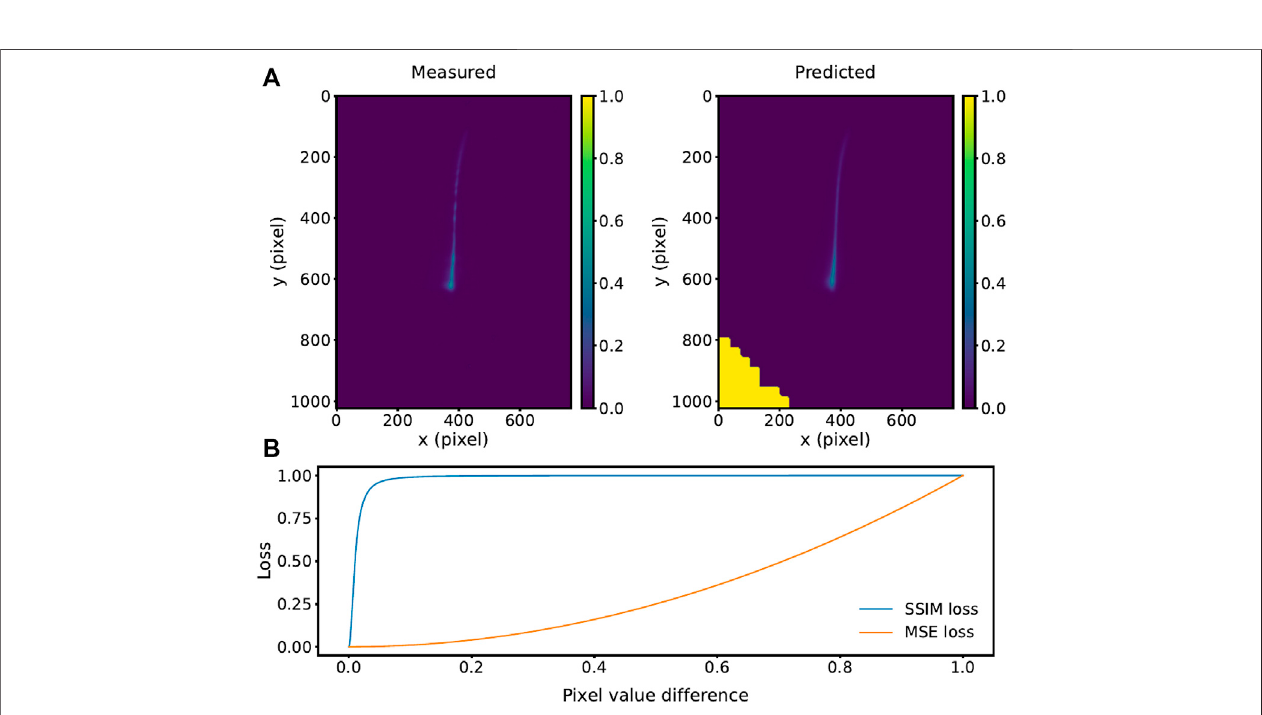
FIGURE 4 | (A) Example of a prediction from a model trained using only the multiscale SSIM loss for the LPS image decoder. The pixel values near the lower-left corner of the predicted image are trapped in values around 1. This phenomenon occurs in all the LPS images. (B) SSIM and MSE losses calculated between two unary images as a function of the pixel value difference. The pixel value of the fi rst image is 0 while the pixel value of the second image ranges from 0 to 1.